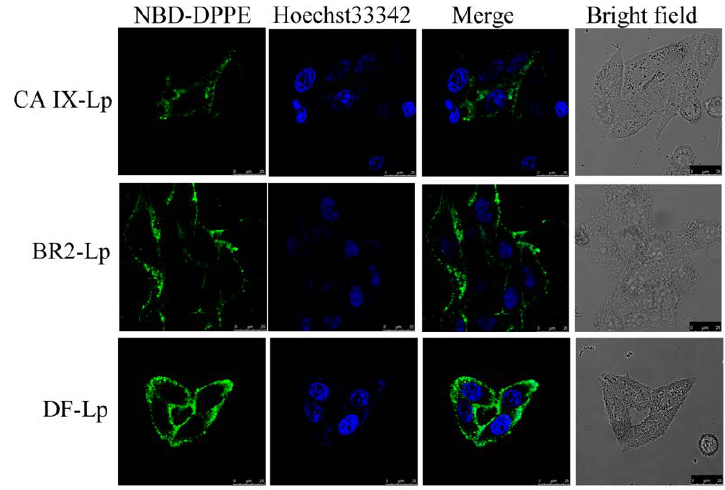
Figure 2. Cell association of NBD-DPPE labeled DF-liposomes compared to BR2-Lp and CA IX-Lp were imaged by CLSM after 3 h incubation with HepG2 cells. Scale bar = 25 µ m. NBD-DPPE labeled liposomes showed green, and nuclei stained with Hoechst 33342 showed